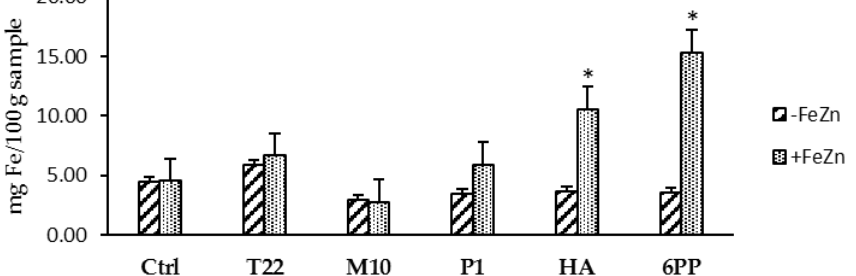
Figure 2. Iron content in lentil plants treated with Trichoderma strains (T22, M10 or P1) or metabolites (HA or 6PP) to the seeds and to the soil (1st watering). Water treatments served as controls (Ctrl). Data represent the mean value of three biological replicates ± standard error. The second soil watering was performed with a 1X solution of iron and zinc (+FeZn) or water ( − FeZn). Asterisks indicate significant differences ( p < 0.05) compared with the control. Statistical analysis was carried out using the one-way ANOVA.